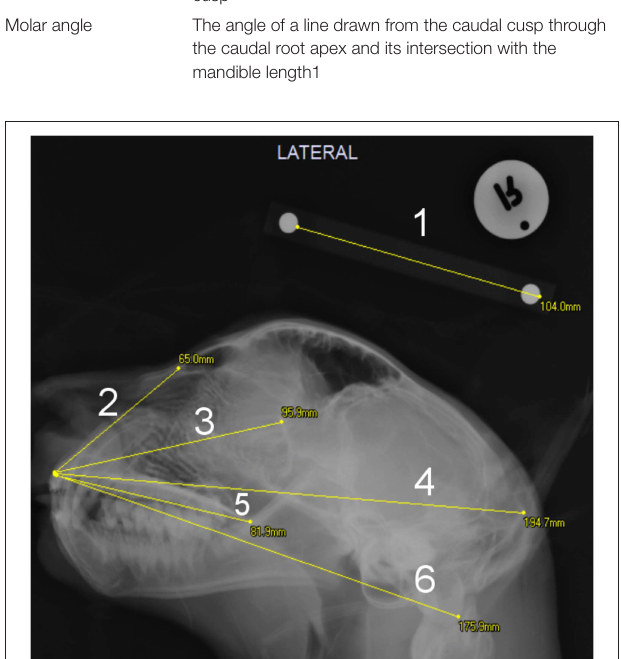
FIGURE 1 | Extent of measurements on the lateral skull radiographs: 1- The 100mm scale barr; 2- Facial length2; 3- Facial length1; 4- Total skull length; 5- Palate length; 6- Condylobasal length.